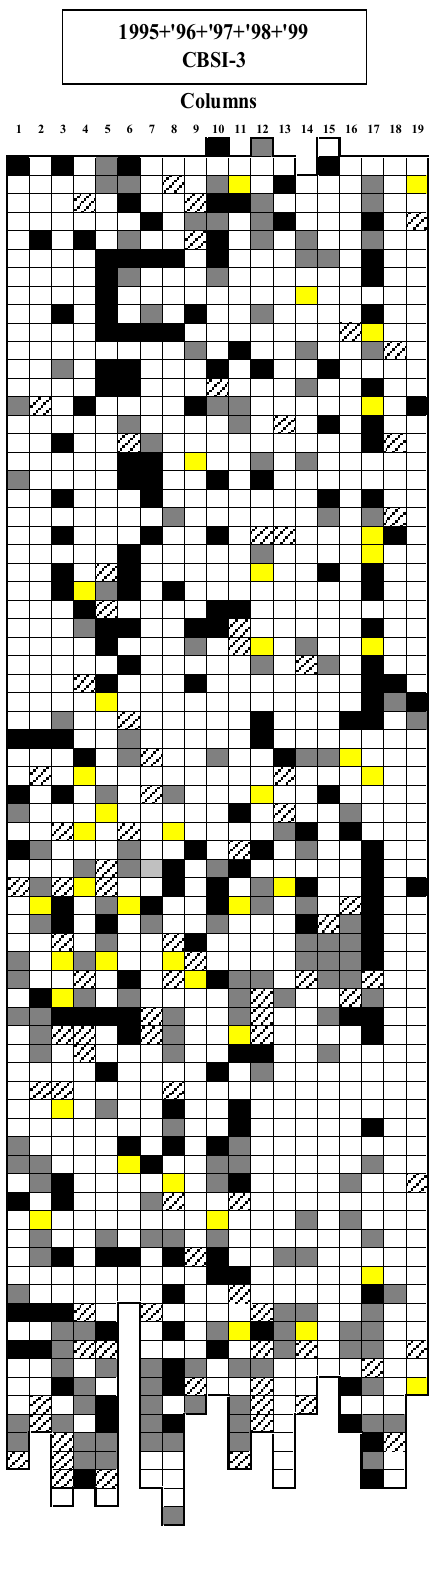
Fig. 2. Vine cultivars planted in each column of vineyard CBSI- 3 (one cv. per